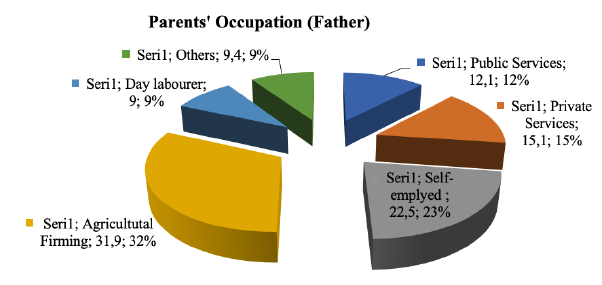
Figure 1: Parent’s Occupation